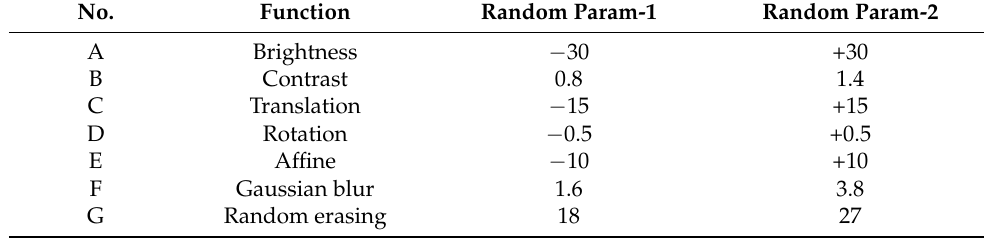
Table 4. Augmentation type and parameter range.